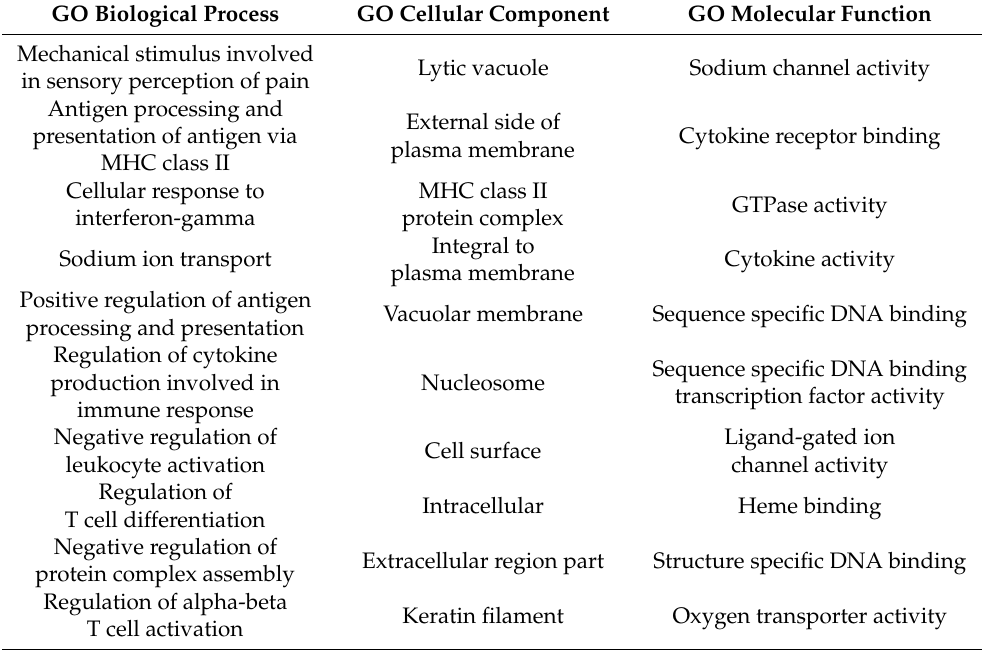
Table 10. Top 10 GO biological processes, cellular components, and molecular functions enriched from differentially expressed genes that are upregulated in MMC spinal cords compared to vehicle at E20. All GO pathways were >1.5-fold and p < 0.05.